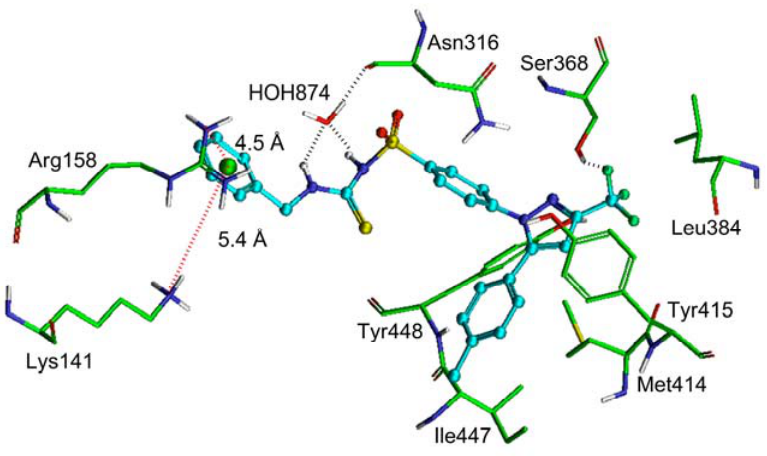
Figure 2. XP-Glide predicted binding mode of compound 1c within palm pocket-I of NS5B. Important amino acids contacting compound 1c are depicted as stick model with the atoms colored as carbon—green, hydrogen—white, nitrogen—blue, oxygen—red and sulfur—yellow. Compound 1c is shown as ball and stick model with the same color scheme as above except carbon atoms are represented in cyan and fluoro atoms in green color. The dotted black line indicates hydrogen bonding interaction whereas the dotted red line indicates cation-pi interaction with distances in